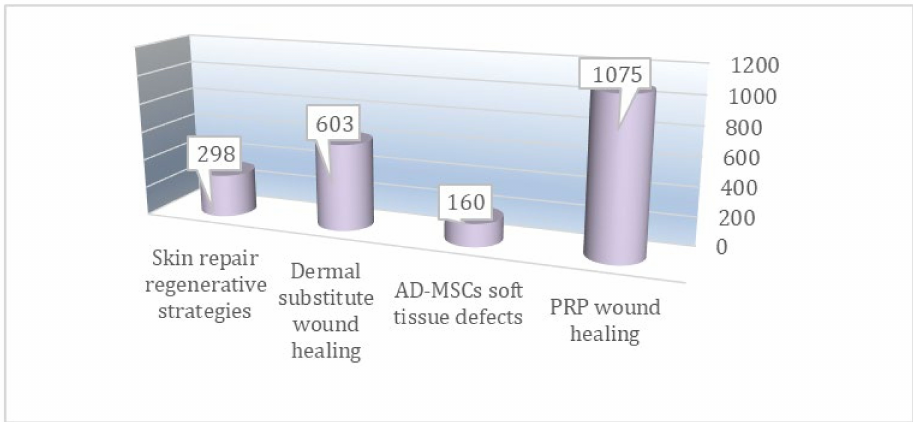
Figure 1. Papers initially found on autologous AD-MSCs, PRP, and biomaterial applications in soft tissue defects and chronic skin